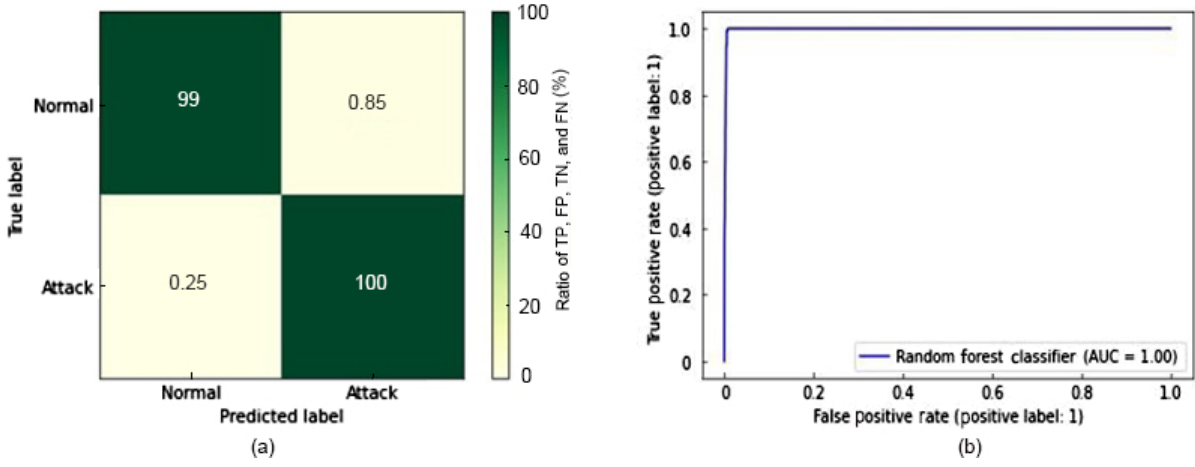
Fig. 12 Confusion matrix and ROC curve of RF on the NF-UNSW-NB15-v2